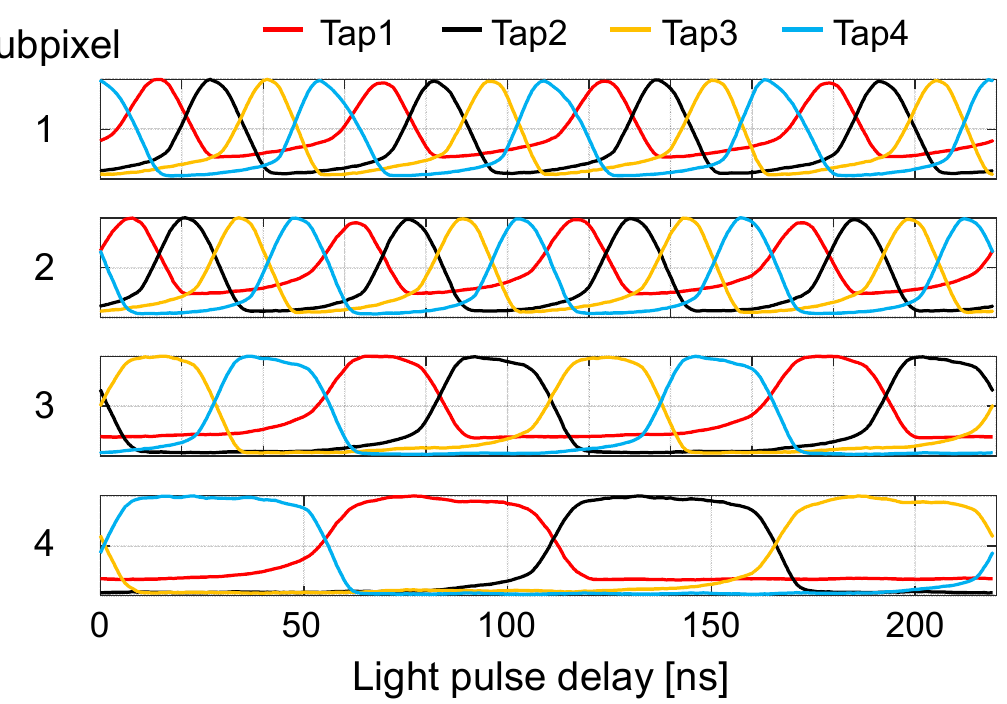
Figure 12. Measured sensor output versus light pulse delay. The waveforms are normalized by the maximum for each tap.